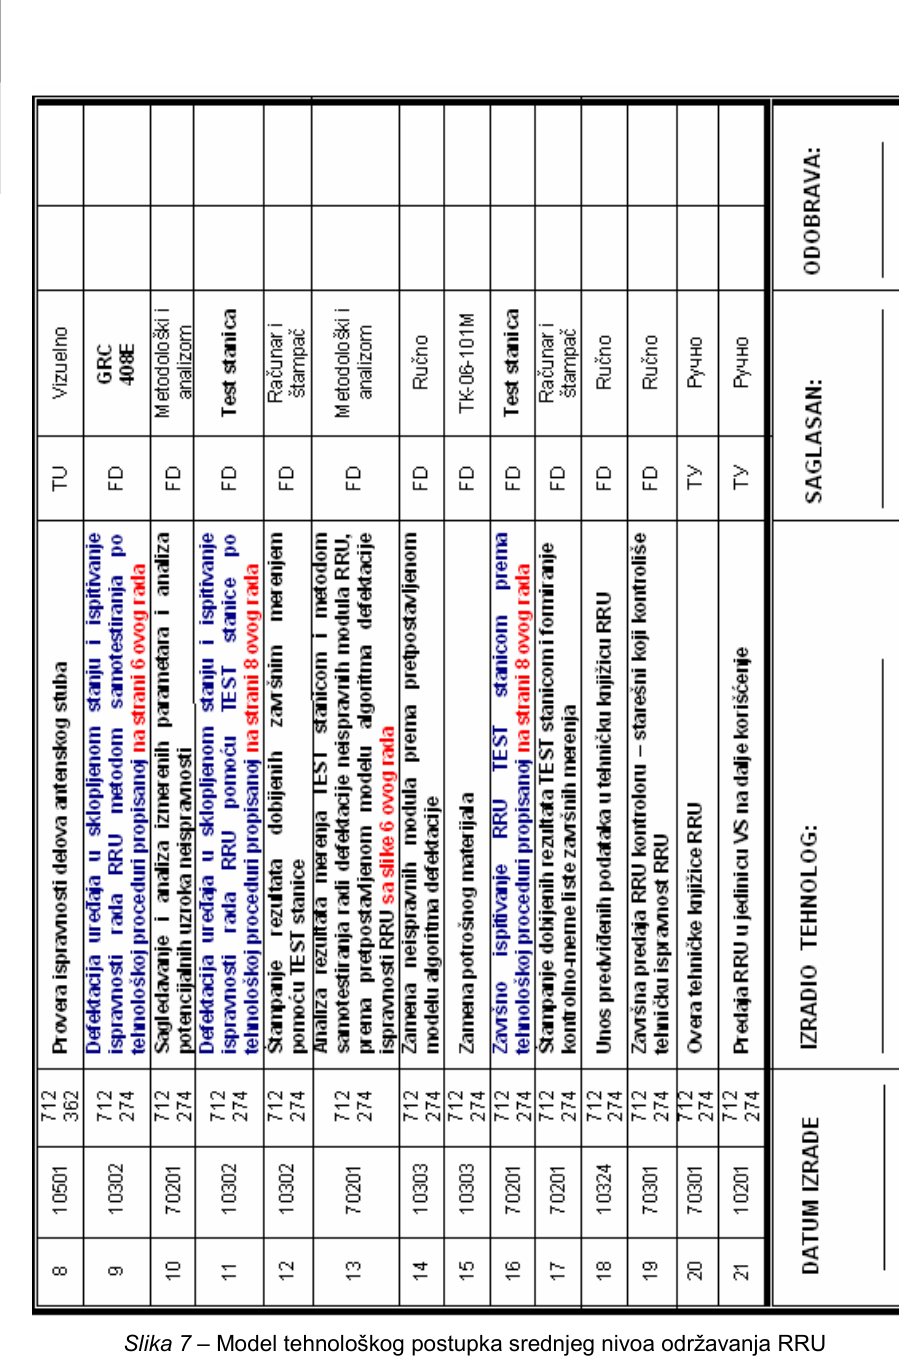
Рис . 7 – Модель технологического процесса среднего уровня поддержки